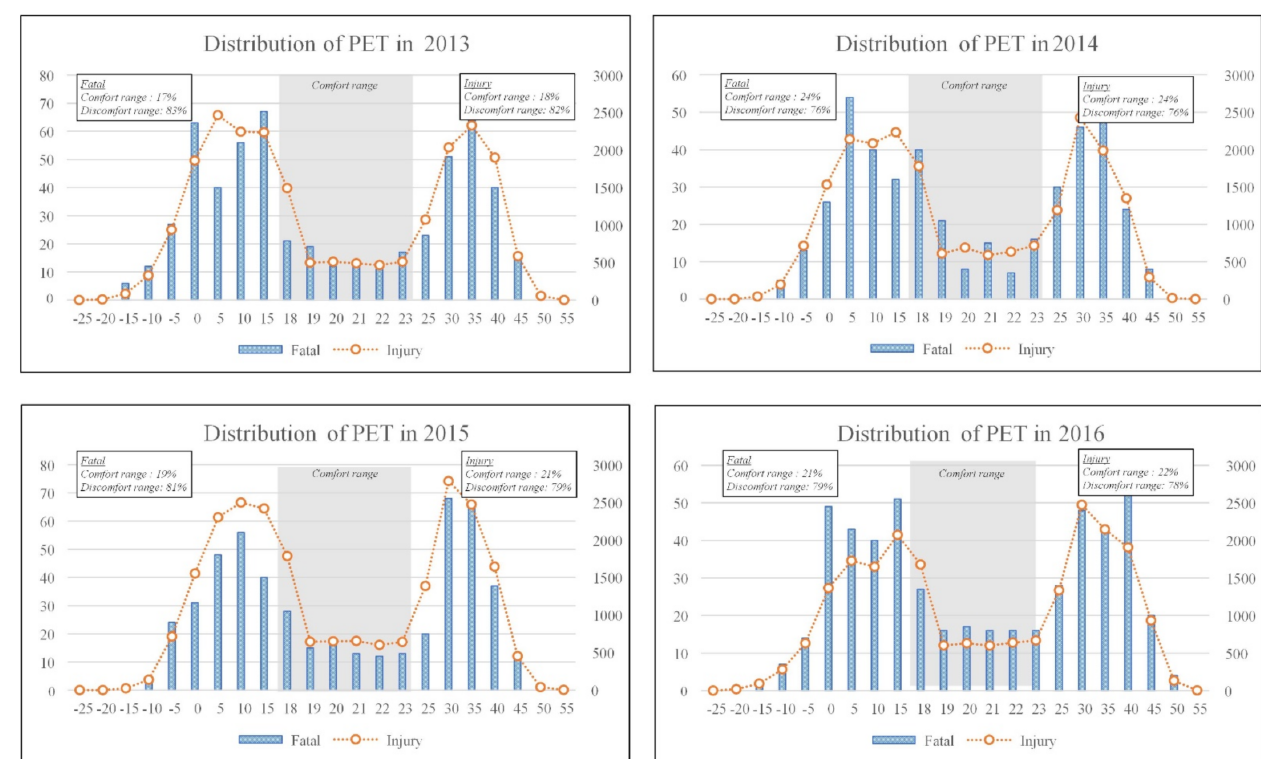
Figure 3. Distribution of physiological equivalent temperature from 2007 to 2016.